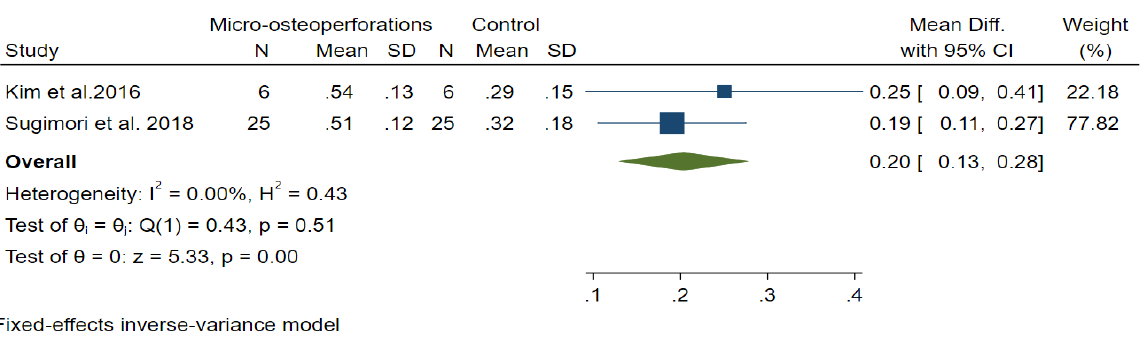
Figure 3. Mean difference of tooth movement with MOP vs. whiteout MOP.